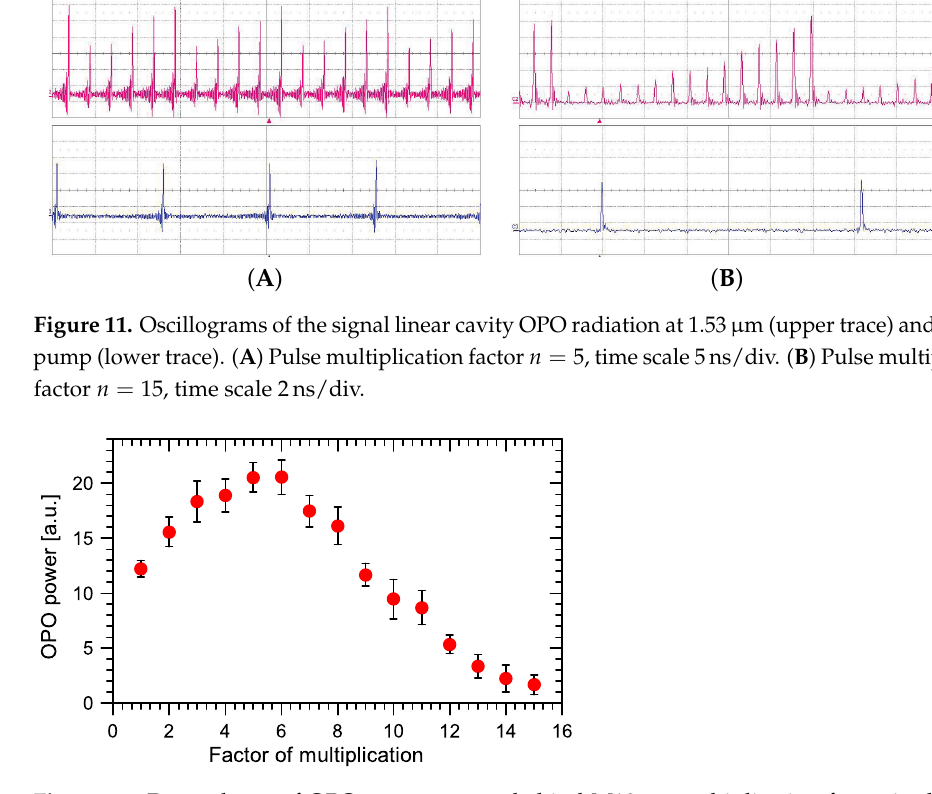
Figure 12. Dependence of OPO output power behind M10 on multiplication factor in the linear OPO